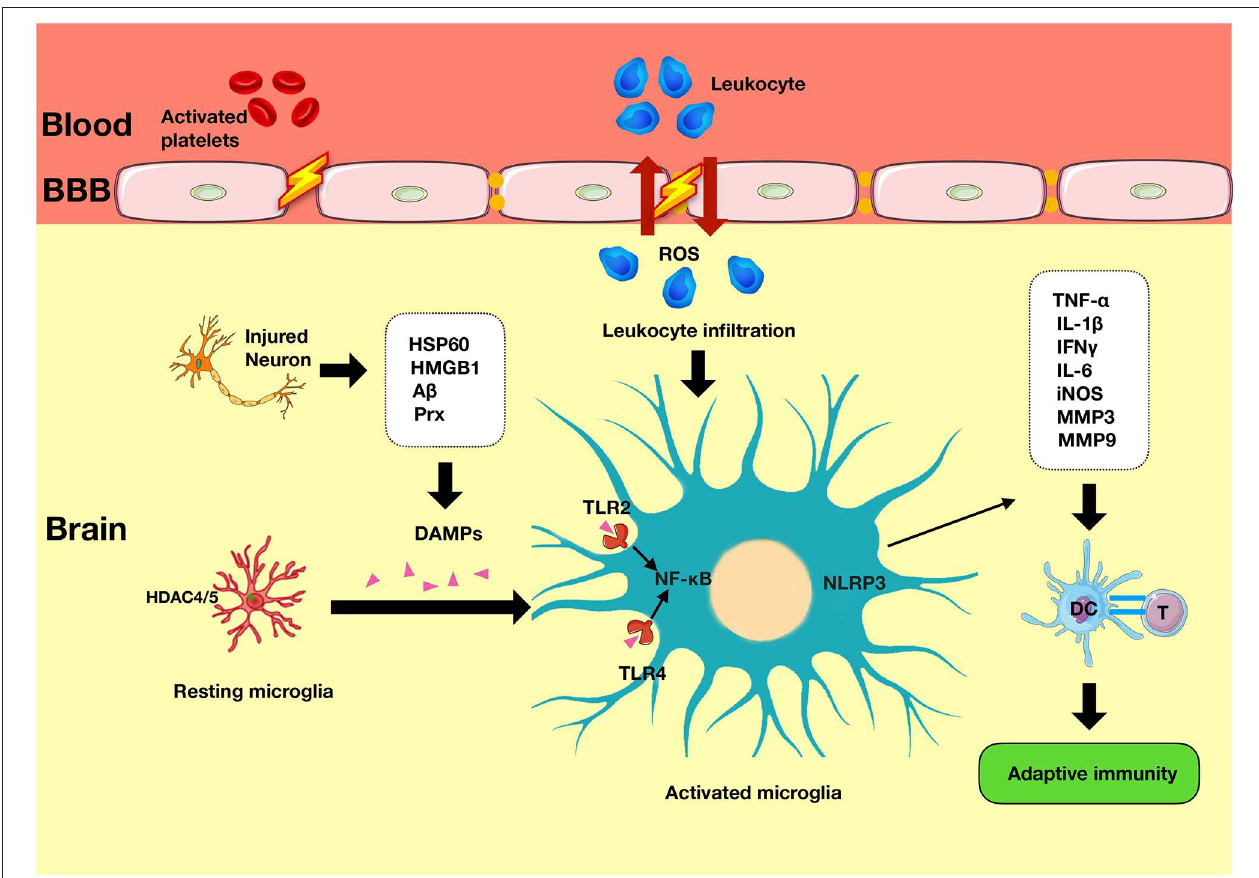
FIGURE 2 | Innate immunity in ischemic stroke. Immediately following an episode of stroke, the innate immune system is activated. It is characterized by the presence of various mediators such as DAMPs that have been released from the injured neurons and which induce the secondary activation of microglia via TLRs signaling and NLRP3 activity. TLR, Toll-like receptors; NLRP3, nod-like receptor pyrin domain-containing 3; APC, antigen-presenting cell; DAMPs, damage-associated molecular